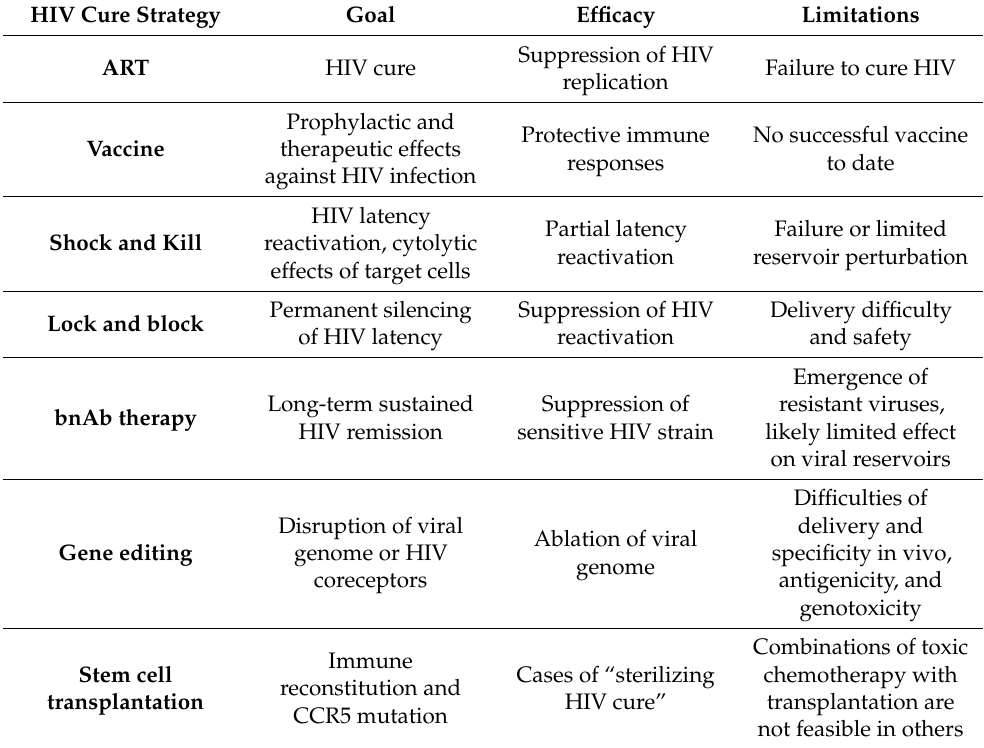
Table 1. General HIV curative